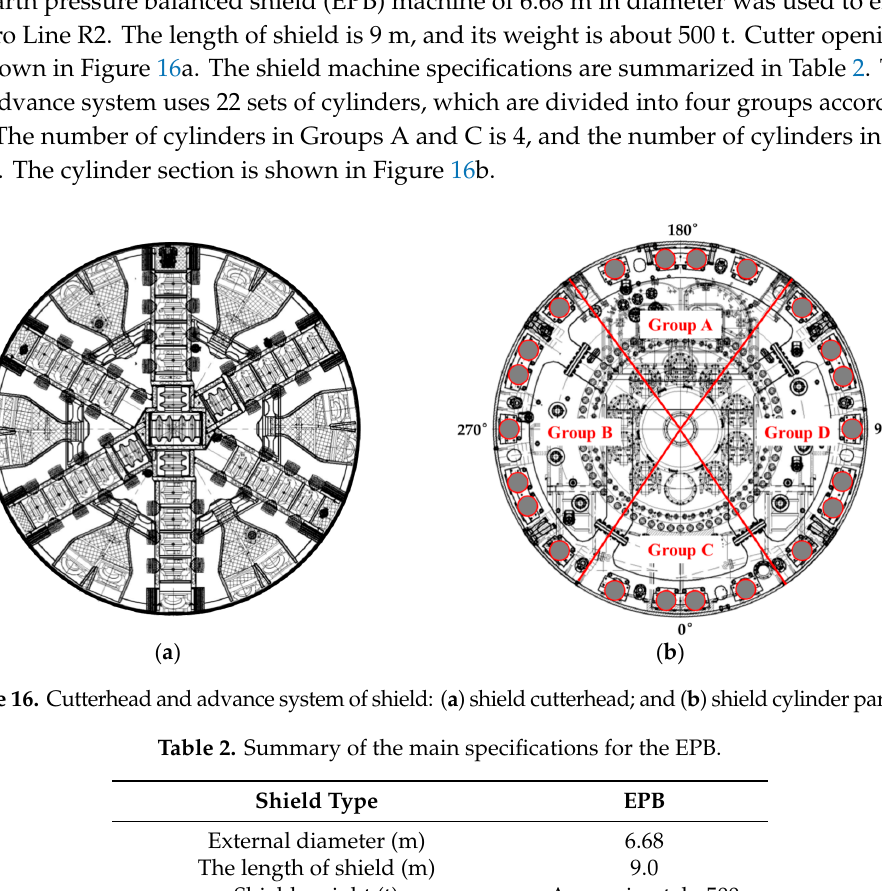
Table 2. Summary of the main specifications for the EPB.